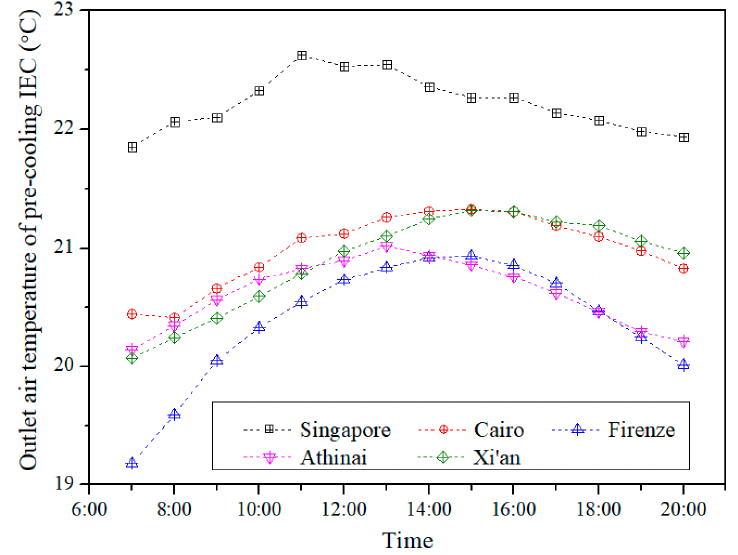
Figure 8. Outlet air temperature of pre-cooling IEC on design days of various climates.